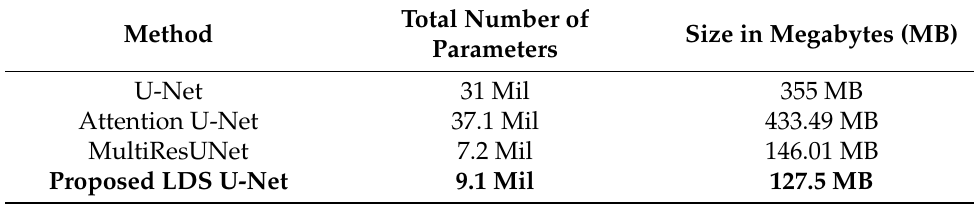
Table 4. Evaluation of computational